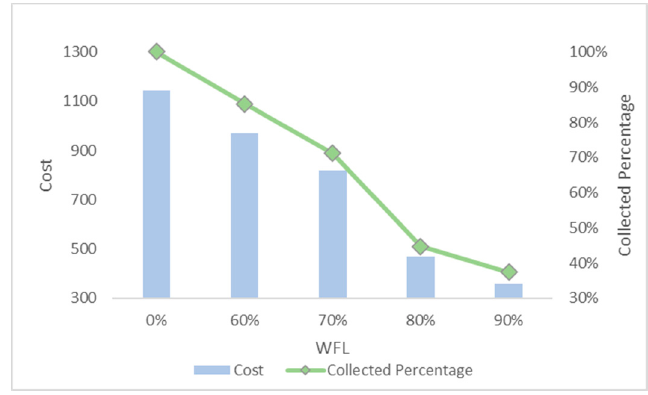
Figure 11. Under different waste filling levels (WFLs). Figure 11. Under di ff erent waste filling levels (WFLs).